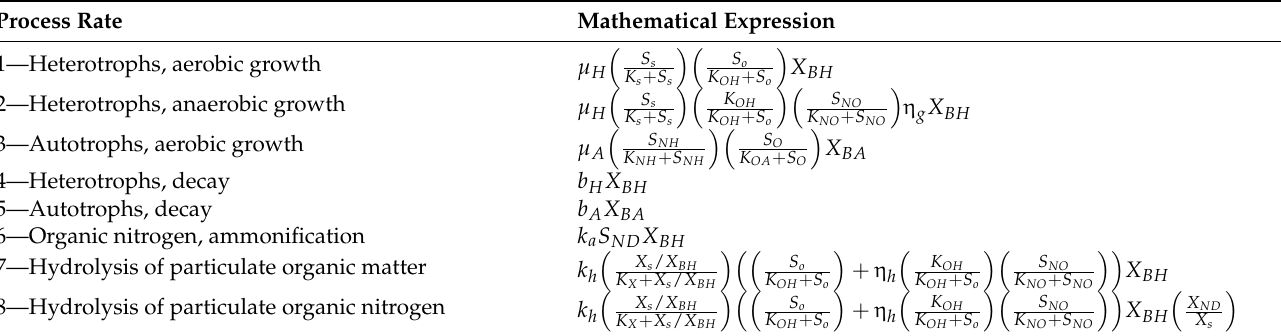
Table 2. Expression of the process rates for ASM1 in accordance with Henze et al. (2000). Numbers of the processes are identified by j